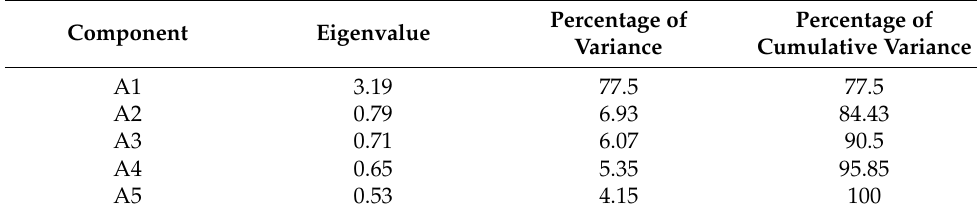
Table 2. Principal component analysis results.